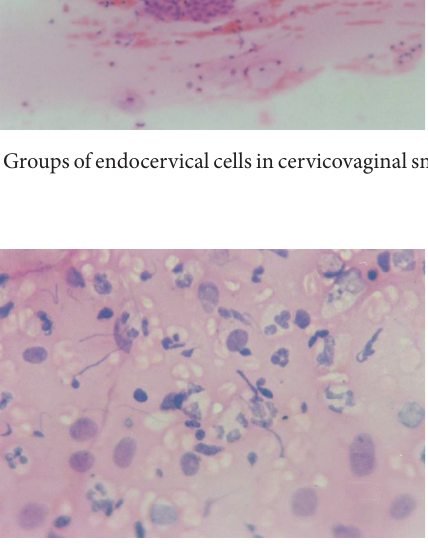
Figure 3: Atypical squamous cells of undetermined origin (ASCUS) (H&E, ×